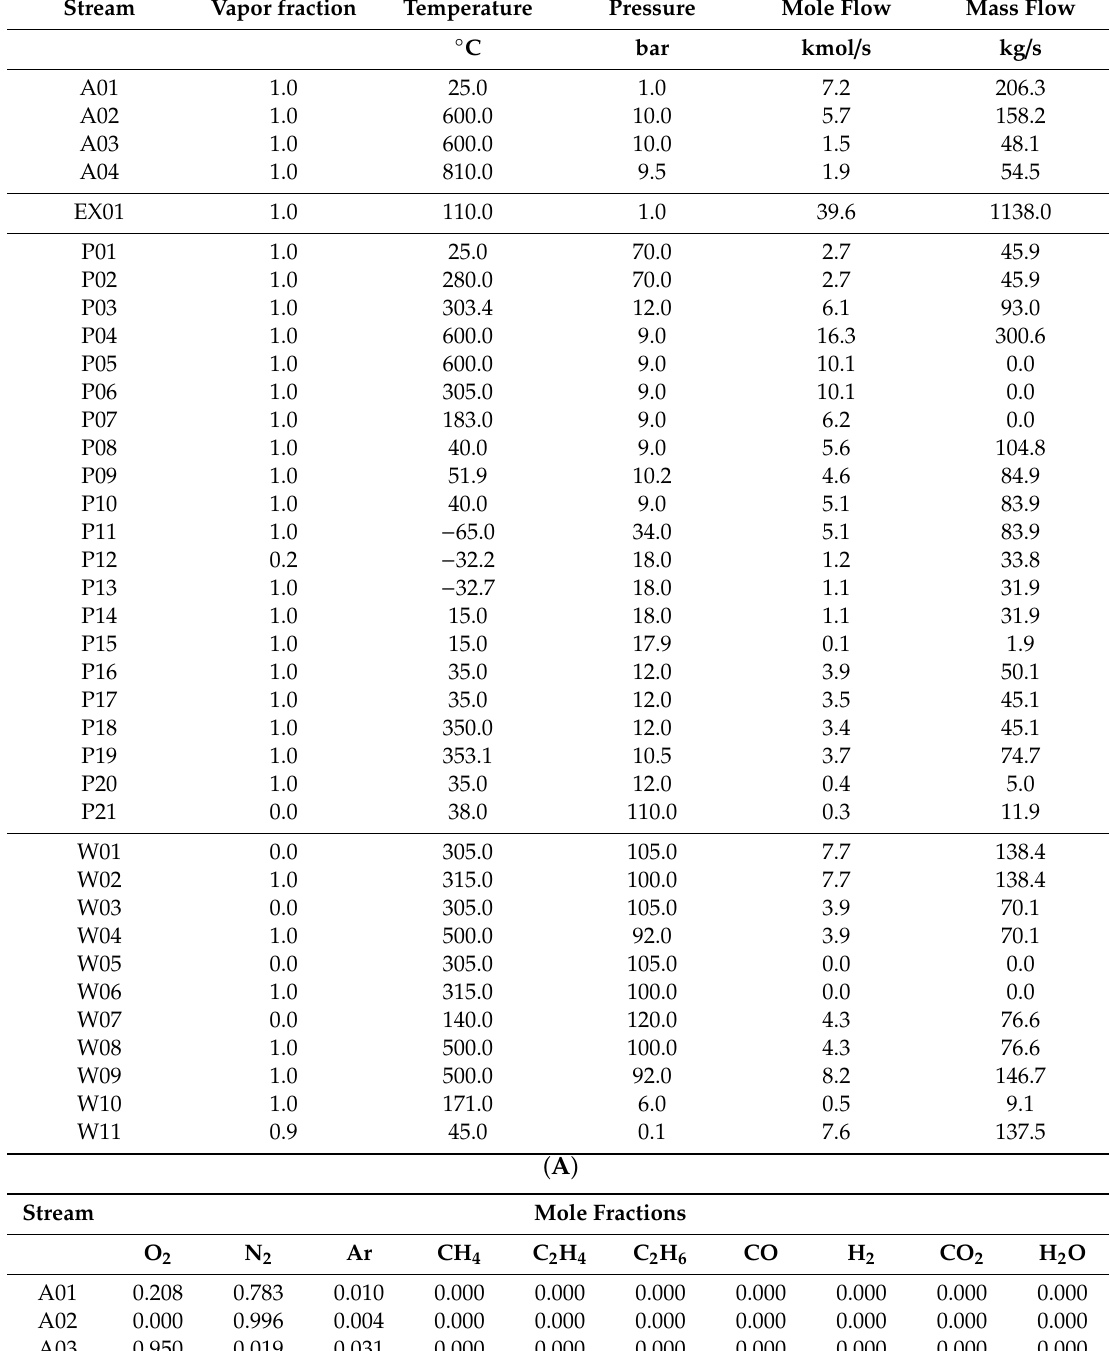
Table A2. OPTIMAL POROUS MEMBRANES